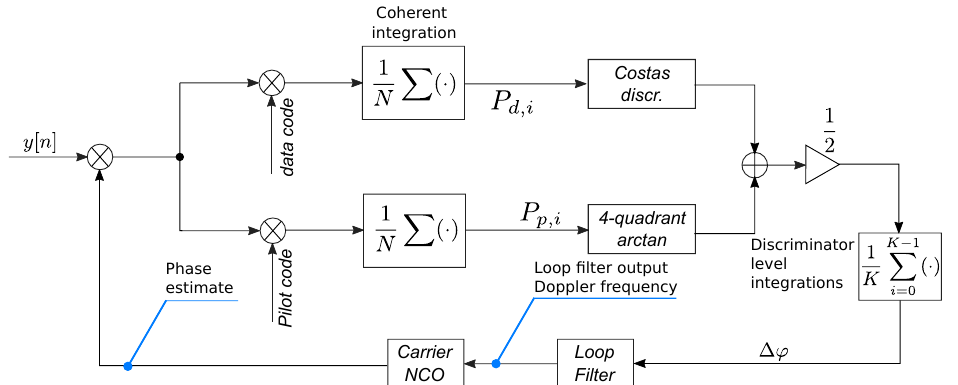
Figure 4. Schematic representation of the OLC PLL integrating extended integrations at the discriminator